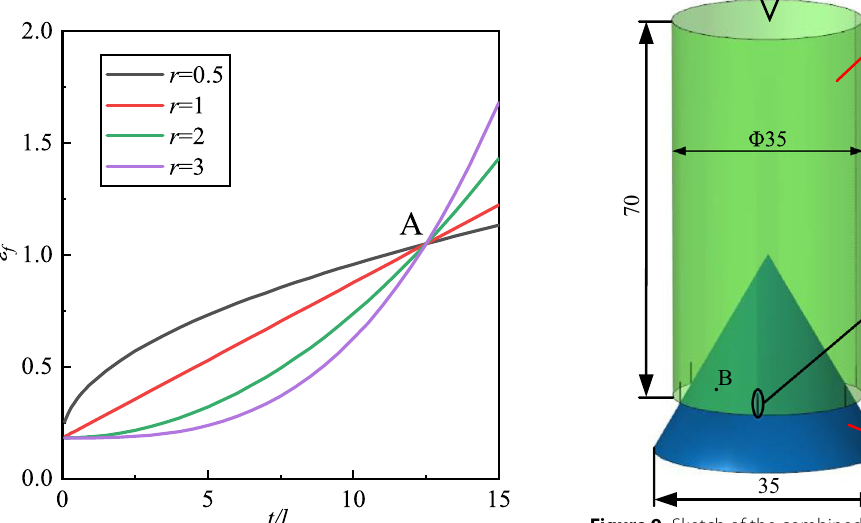
Figure 8 Variation of failure strain with element size